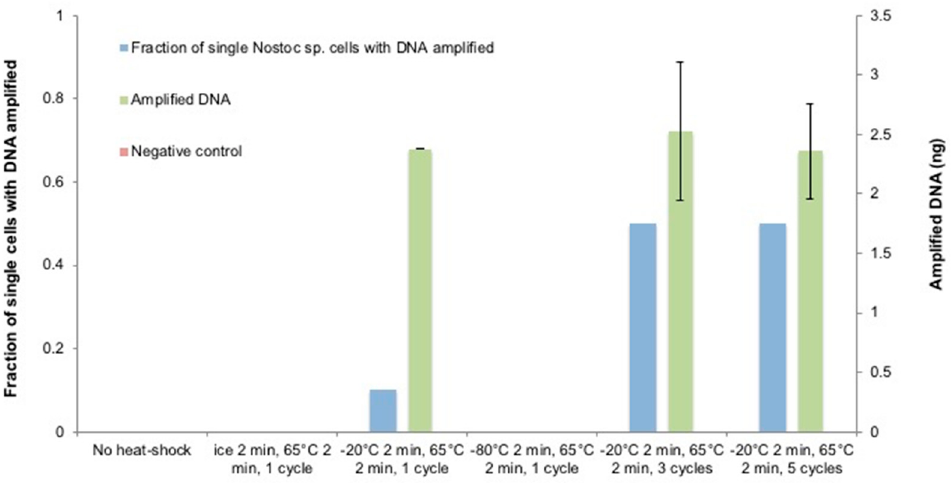
Figure 7. The temperature range effect and cycles of heat-shock on Nostoc sp. lysis for SC-WGA. After heat-shock treatment, a mixture of 200 U/µL Ready-Lyse lysozyme and 0.5 mM EDTA was added and incubated at 37 °C for 2 h. The D2 alkaline lysis buffer was then added and incubated at 65 °C for 2 h. N = 10 single cells per condition; error bars represent standard deviation.